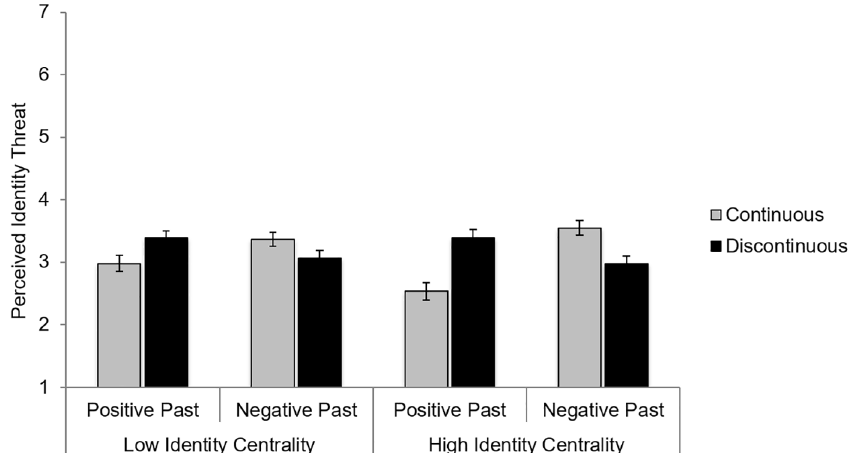
Figure 2. Perceived identity threat depending on whether the in-group’s history is perceived as continuous or discontinuous and the valence of the past episode separated by high versus low identity centrality based on a median split ( Mdn = 4.00 on a 7-point scale) for ease of presentation. Note . Error bars represent standard